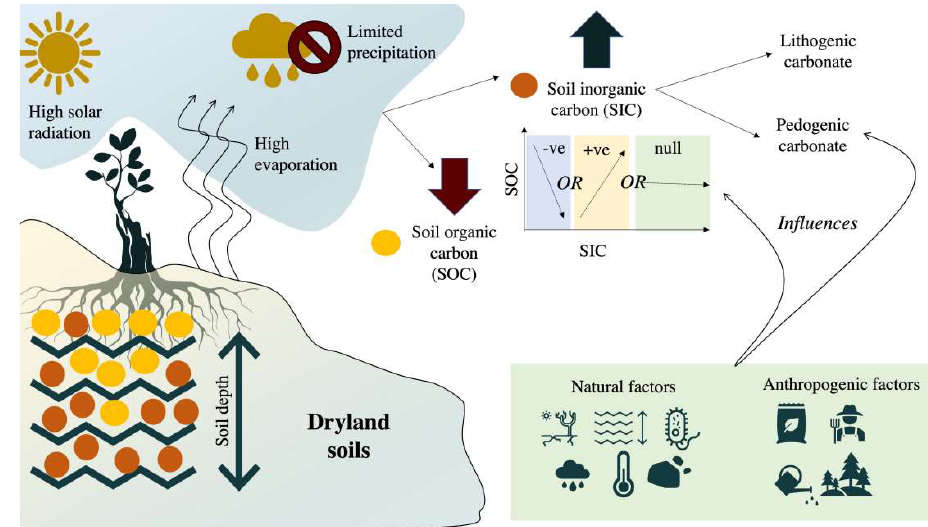
Figure 4. Mechanism of SIC formation in soil (Naorem, A